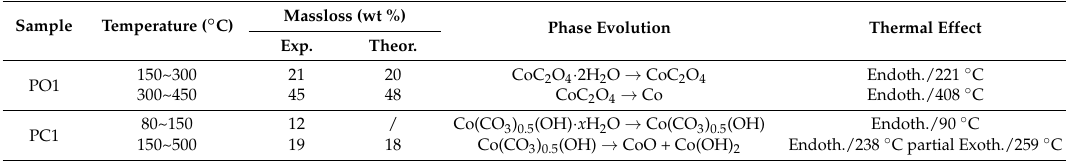
Table 4. Thermal decomposition analysis for